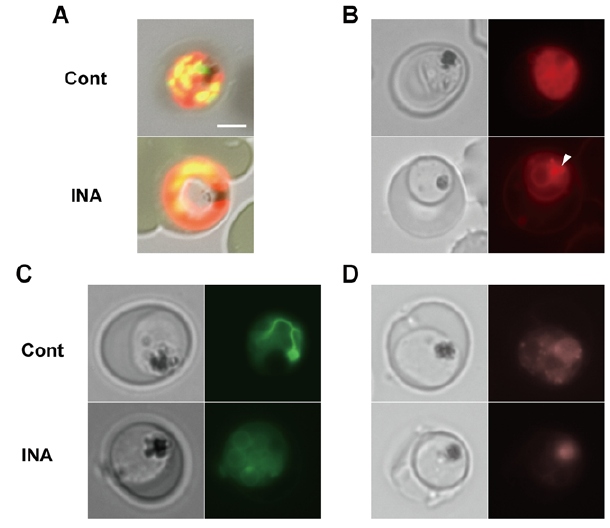
Figure 3. Fluorescence microscopy of INA-treated parasites. Infected erythrocytes were stained with (A) acridine orange, (B) Nile Red, (C) rhodamine 123 and (D) LysoTracker TM Red DND-99. INA was introduced at: (A) 100 m M for 9 h, (B) 50 m M for 6 h, and (C and D) 50 m M for 4 h. 100 m g/ml acridine orange was applied to thin blood smears made from intraerythrocytic parasites treated with INA. For other fluorescence dyes, P. falciparum cultures were incubated with probes for 1 h at the following concentrations: Nile Red, 1 m g/ml; rhodamine 123, 10 ng/ml; and LysoTracker H Red DND-99, 75 nM. Cells were not washed prior to fluorescence microscopy to minimize damage due to osmotic changes. Scale bar, 3 m m. An arrow indicates a lipid body in (B).